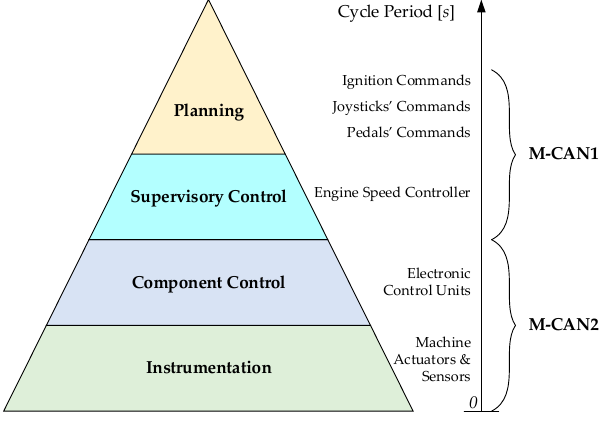
Figure 7. Hierarchical decomposition and CAN structure of the machine control system.